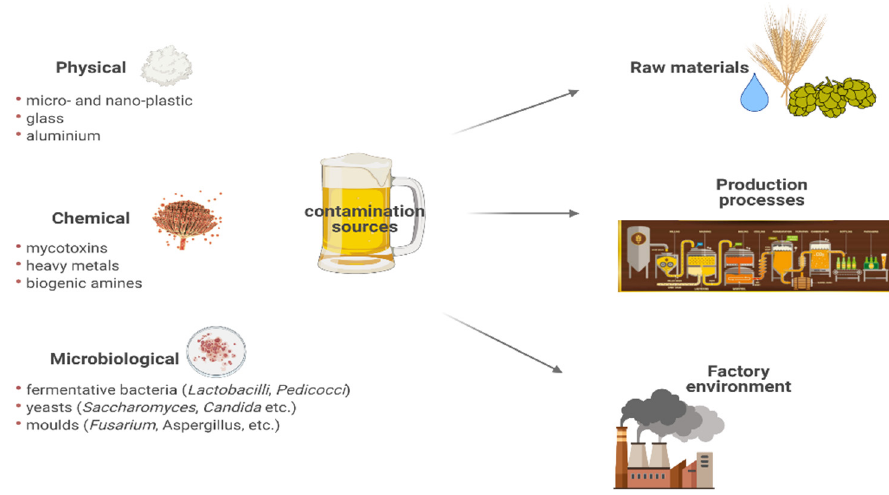
Figure 1. Beer contamination sources.